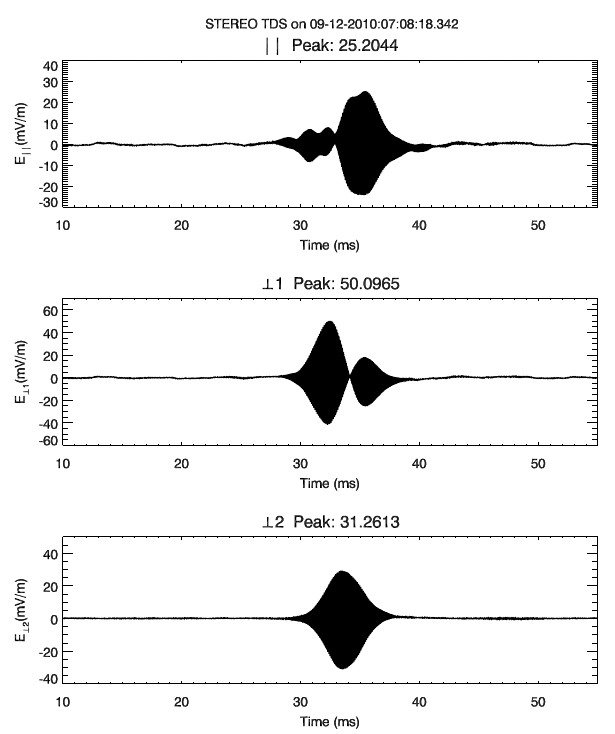
Fig. 3. The parallel (panel a ) and perpendicular (panels b and c ) electric field components of the Langmuir wave packet with respect to the magnetic field. The normalized vectors of magnetic field and solar wind velocity used in this trans- formation are B = [− 0 . 60918 , − 0 . 39479 , − 0 . 69389 ] and v sw = [ 0 . 99335 , − 0 . 10097 , − 0 . 055360 ] , respectively. The angle between the magnetic field and solar wind velocity in this case is ∼ 122